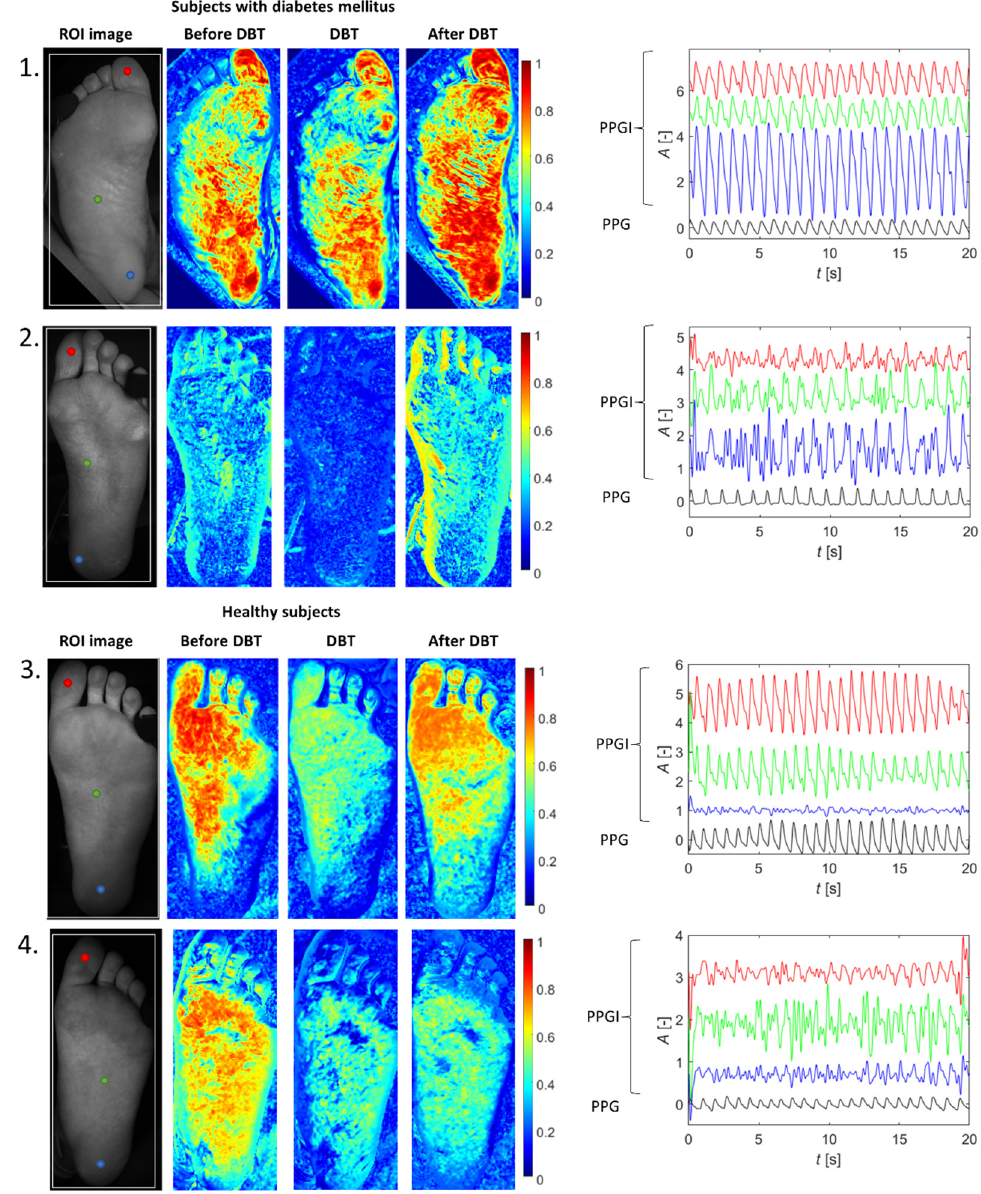
Figure 6. Correlation maps of DM (1,2) and healthy (3,4) subjects (one subject in a row). The first column shows a frame from the recording with a bounded region of interest (white rectangle). The coloured maps represent the output from the correlation mapping script before, during, and after the DBT, respectively. In the right part, there are the signals from the places marked on the first column (the colours of the signals correspond to the marked points). The black signal is the PPG obtained with the BIOPAC device from the little toe of the proband’s foot.